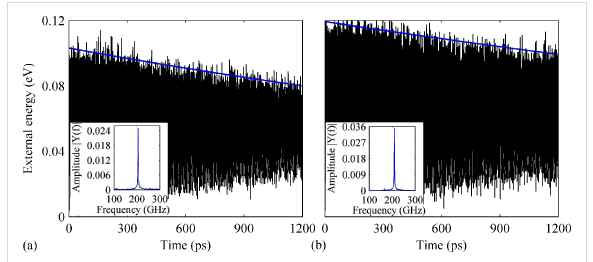
Figure 10: Variation over time of the external energy for the defective GNR (four vacancies) with both B- and N-dopants. The total densities of dopants are (a) 0.76% and (b) 1.76%. The insets show the corres- ponding frequency spectra.